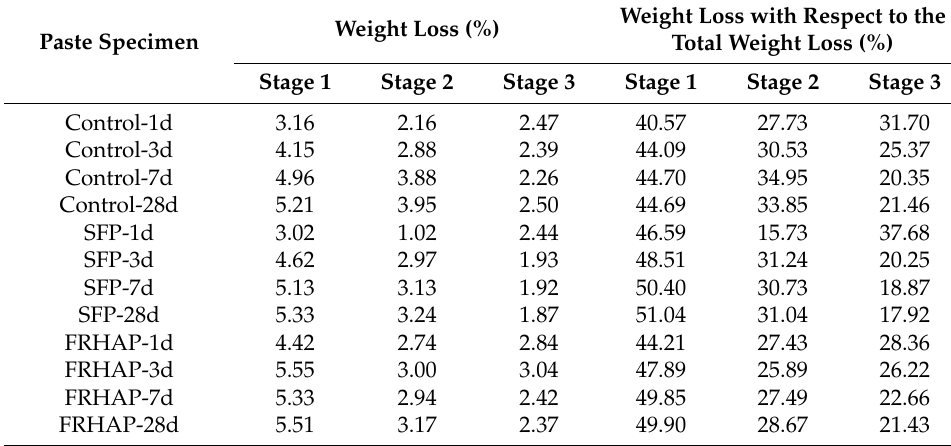
Table 4. Weight losses of pastes at the ages of 1, 3, 7 and 28 days. Weight Loss with Respect to Weight Loss (%) Paste Specimen